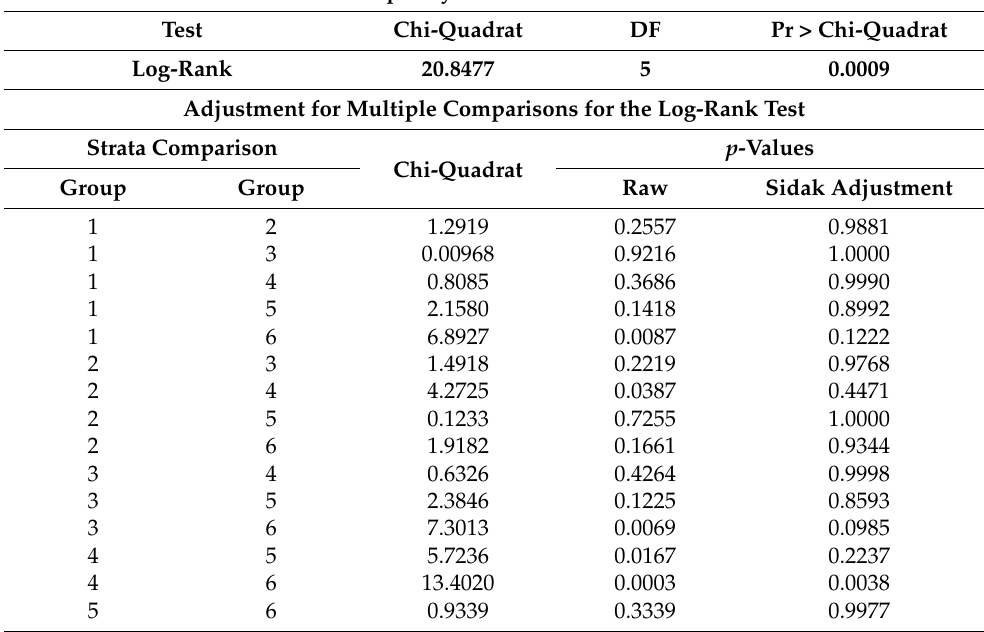
Table 2. Statistical comparison of the survival curves using a log-rank test. Group 1 was immunized with scFv-1.2.2.H9, group 2 received scFv-Fc-1.2.2.H9. Group 3 was immunized with IgG1-1.2.2.H9. The positive group 4 was treated with pAb anti-MVA. The negative controls, group 5 and 6, received anti-EHV1 6B11 mAb and PBS, respectively. Equality Test over Levels Test Chi-Quadrat